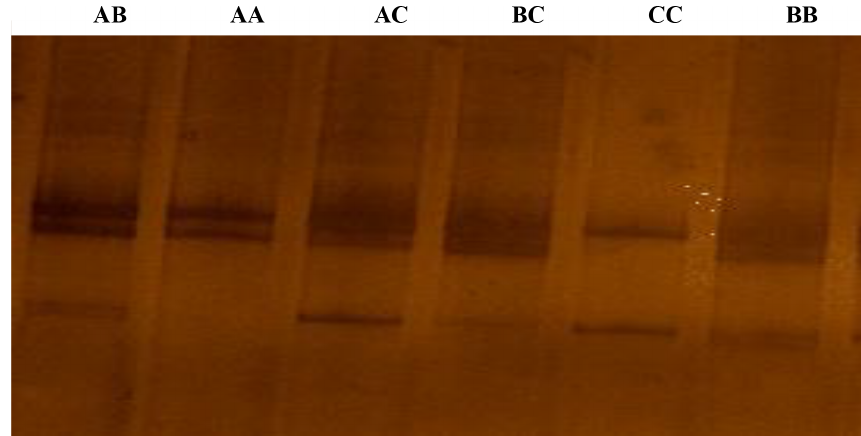
Figure 1. The SSCP conformation patterns of the ovine KAP22-1 in Egyptian sheep. Three different alleles were identified (A, B and C).